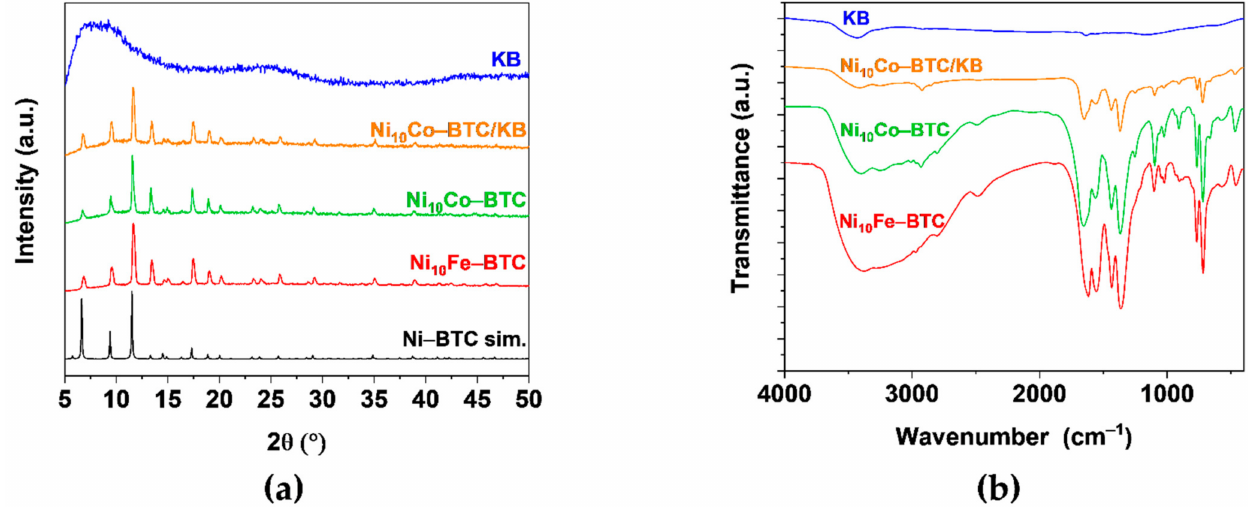
Figure 2. ( a ) PXRD patterns of experimental Ni 10 Fe-BTC (red), Ni 10 Co-BTC (green), Ni 10 Co-BTC/KB (orange), KB (blue) and simulated Ni-BTC (black) (CCDC Nr. 802889); ( b ) FT-IR spectra of Ni 10 Fe-BTC (red), Ni 10 Co-BTC (green), Ni 10 Co-BTC/KB (orange) and KB (blue).